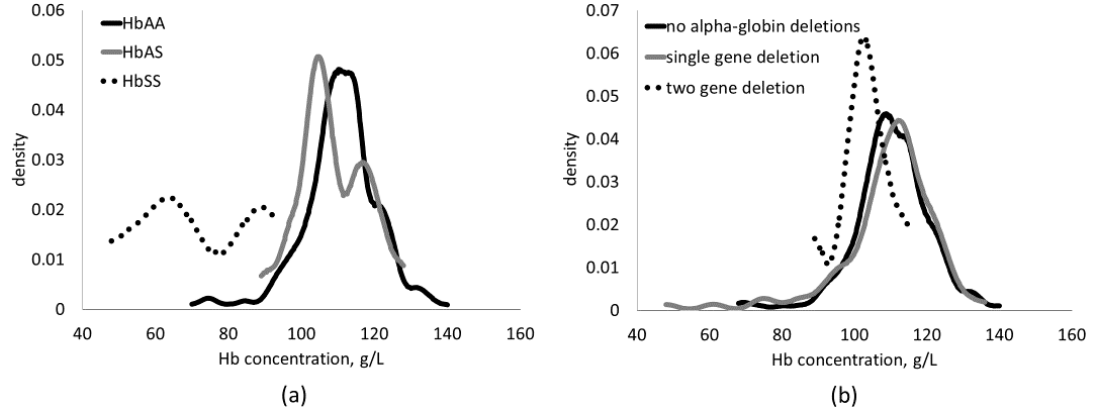
Figure 1. Kernel density plots illustrating the distribution of hemoglobin concentrations among: ( a ) children with HbAA ( n = 250), HbAS ( n = 40), and Hb SS ( n = 5) genotypes; and ( b ) among children with none ( n = 190; α α / α α ), one ( n = 89; α –/ α α ), or two ( n = 9; α –/ α –) alpha-globin deletions.